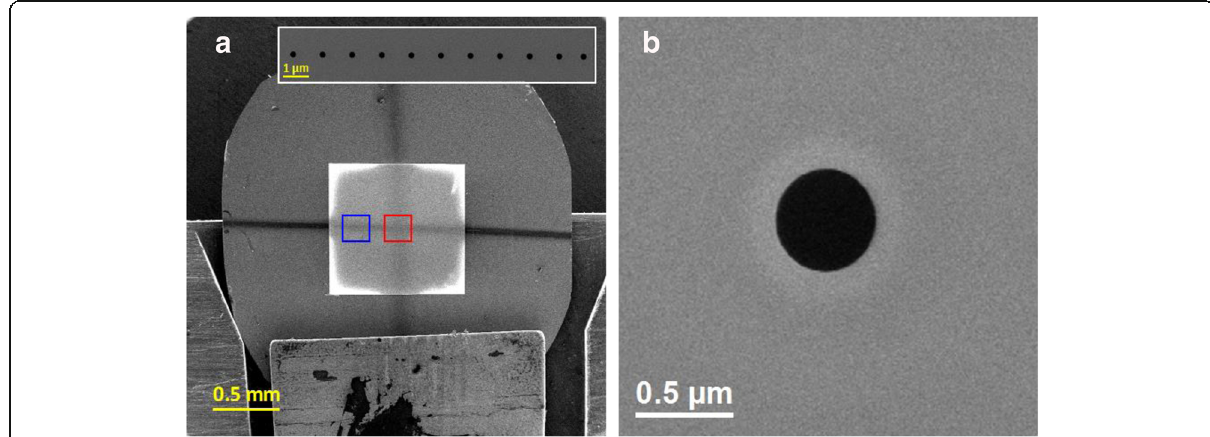
Fig. 3 a SEM image of the SiN membrane TEM window grid (the inset shows the guide-hole array). b An individual nanohole fabricated by FIB